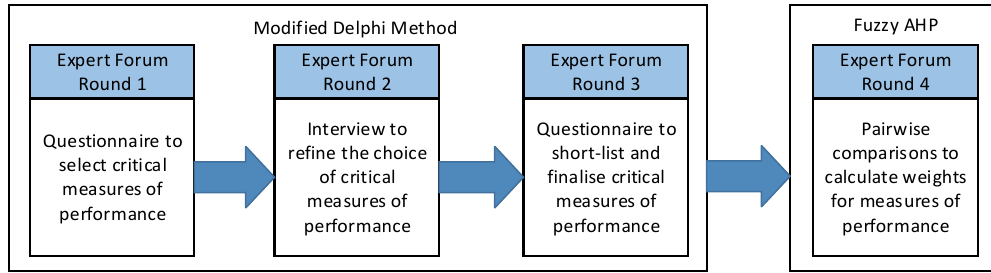
Figure 1. Research methodology.